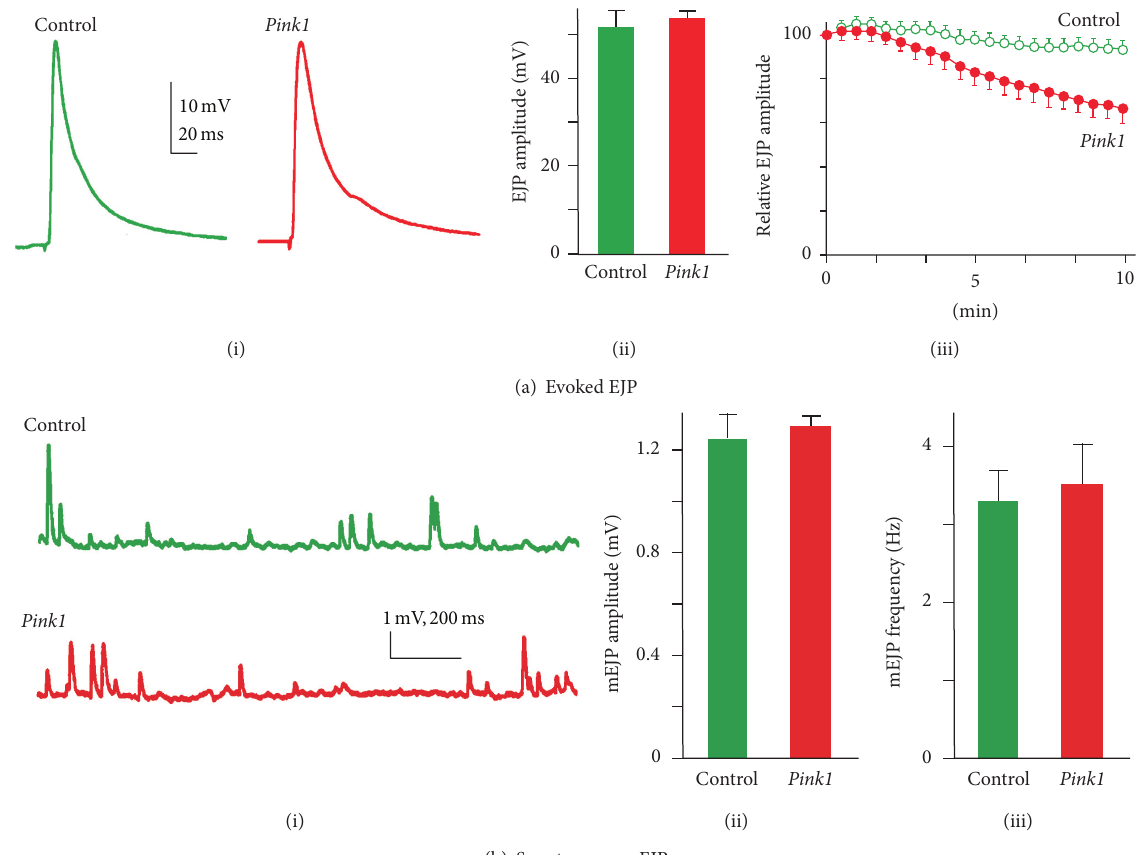
Figure 2: Pink1 mutants display a progressive decline in synaptic transmission under high frequency stimulation. ((a)i-ii) Pink1 ( Pink1 B9 ) mutants showed no perturbation to basal neurotransmitter release properties, with no significant difference in the amplitude of evoked excitatory junction potentials (EJP) observed between Pink1 mutants and controls. ((a)iii) Under high frequency stimulation (10min, 10 Hz) Pink1 mutants showed a substantial, progressive decline in synaptic transmission when compared to controls. ((b)i–iii) Pink1 mutants showed no significant difference in spontaneous miniature EJP (mEJP) amplitude (i-ii) or frequency (i and iii) when compared to controls. Adapted from